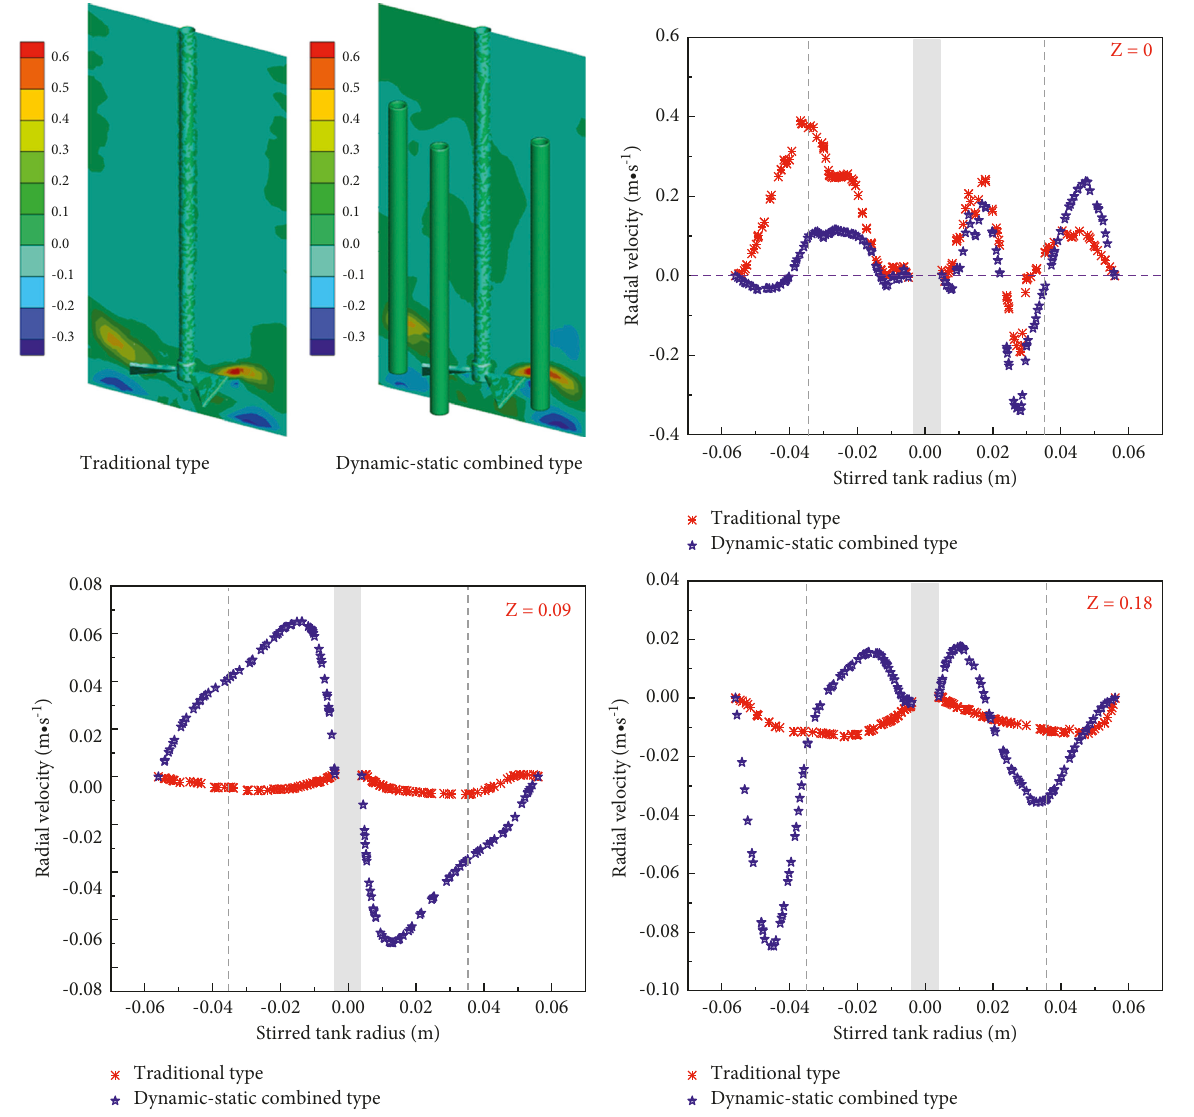
Figure 10: The radial velocity distribution at different planes ( Z � 0, Z � 0.09, Z �